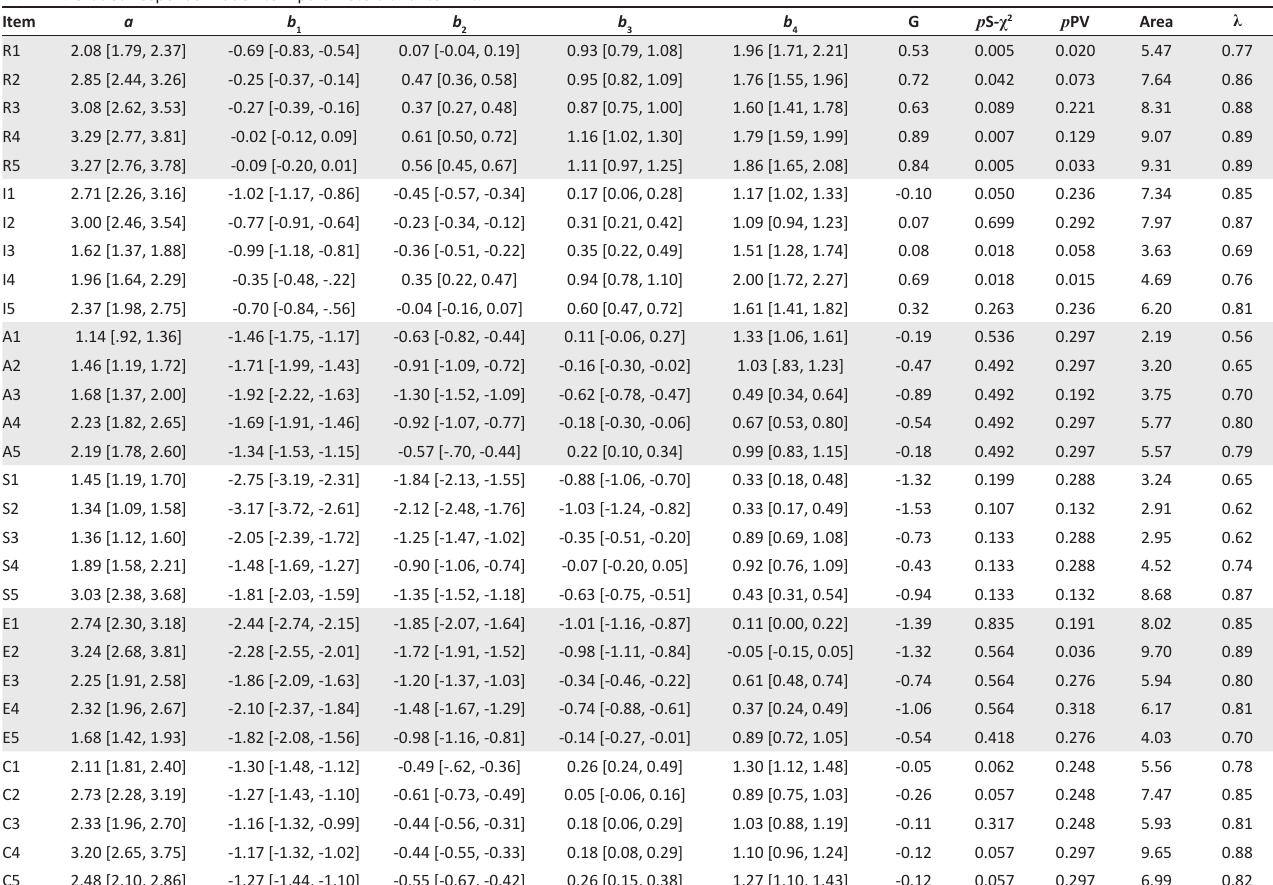
TABLE 2: Graded response model item parameters and item